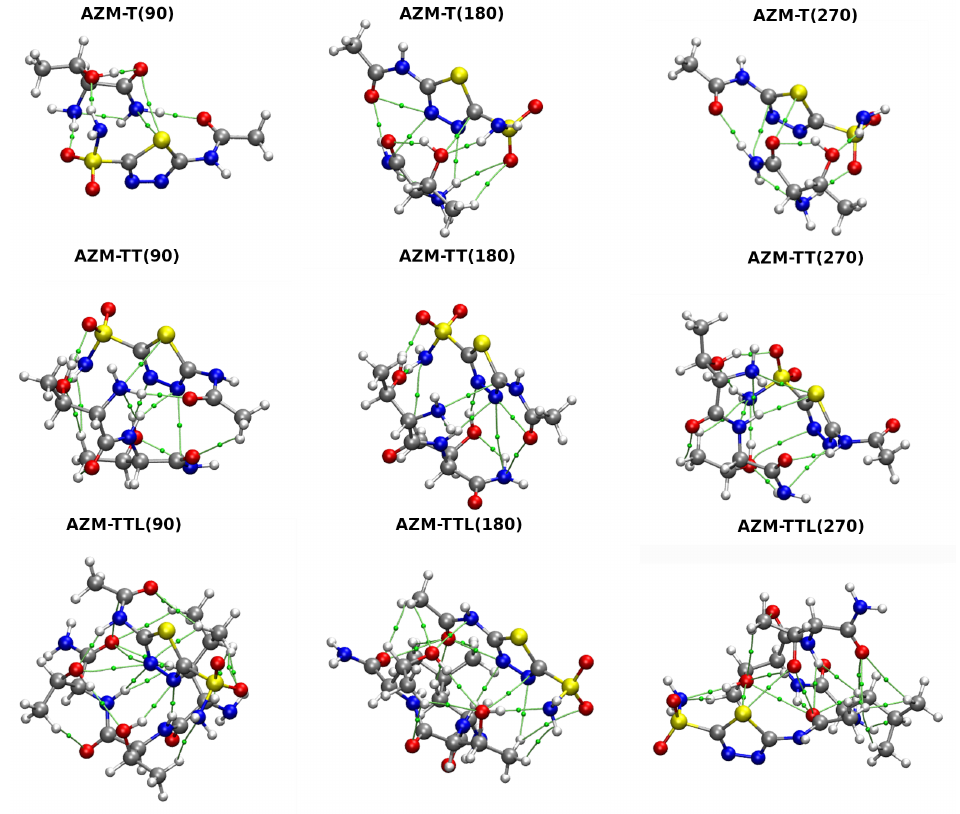
Figure 7. Atoms in Molecules (AIM) molecular graphs for AZM complexes subjected to the S1-C2- N4-C1 torsional angle rotation. Numbers in parentheses denote the torsional angle values in [ ◦ ]. Only BCPs of non-covalent interactions are presented, and they are marked as small green spheres. The simulations were performed at the M06/aug-cc-pVDZ level of